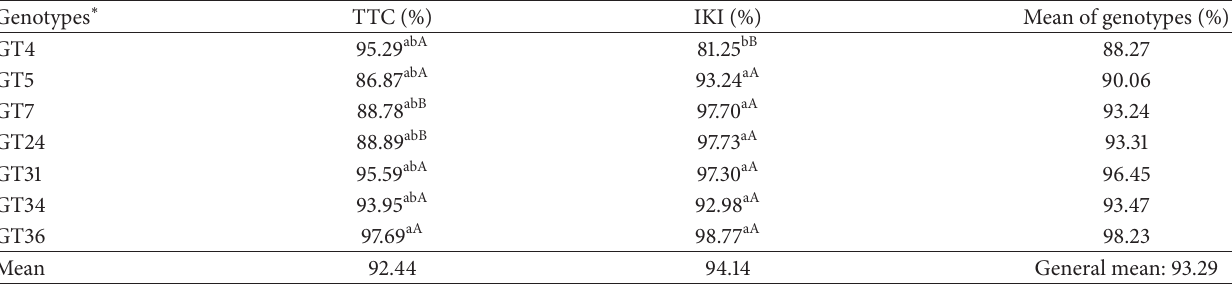
Table 1: Pollen viability of cherry laurel genotypes determined by TTC and IKI tests.